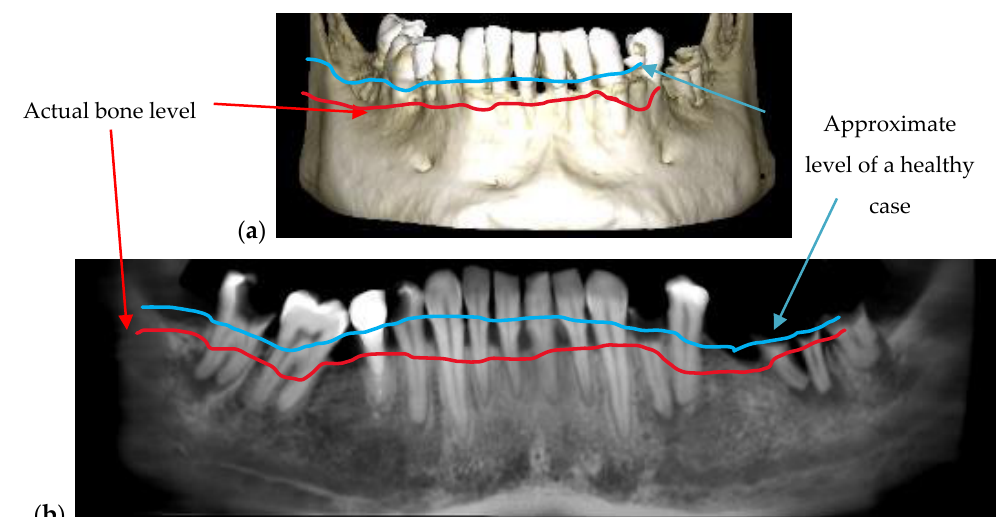
Figure 5. Periodontitis disease observed on a 3D CBCT reconstruction ( a ) and on a panoramic radiography ( b ). Patient C.O., male, age 34 years, diagnosed with periodontitis, alongside other dental issues such as cavities and dental abscesses.